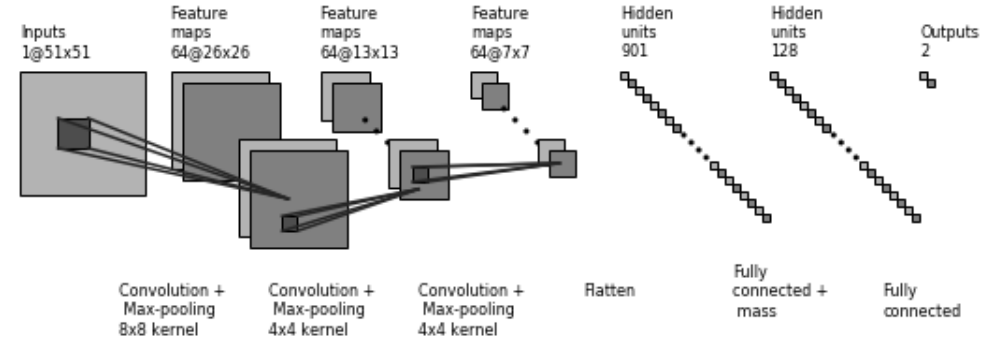
Figure 2: Network architecture of the CNN. This figure was generated by adapting the code from https://github.com/gwding/draw_convnet .